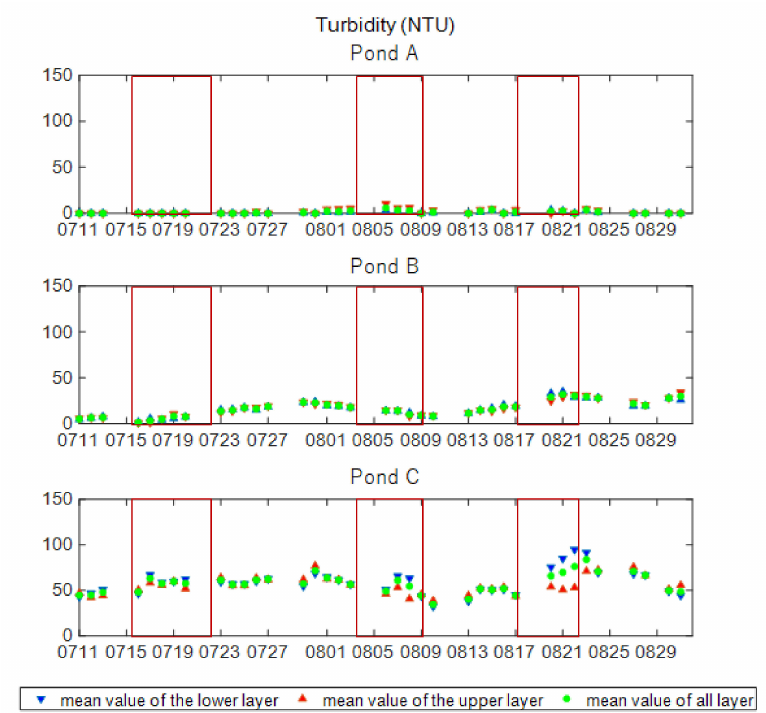
Figure 10. Mean turbidity value for the lower layer, upper layer, and all layers.